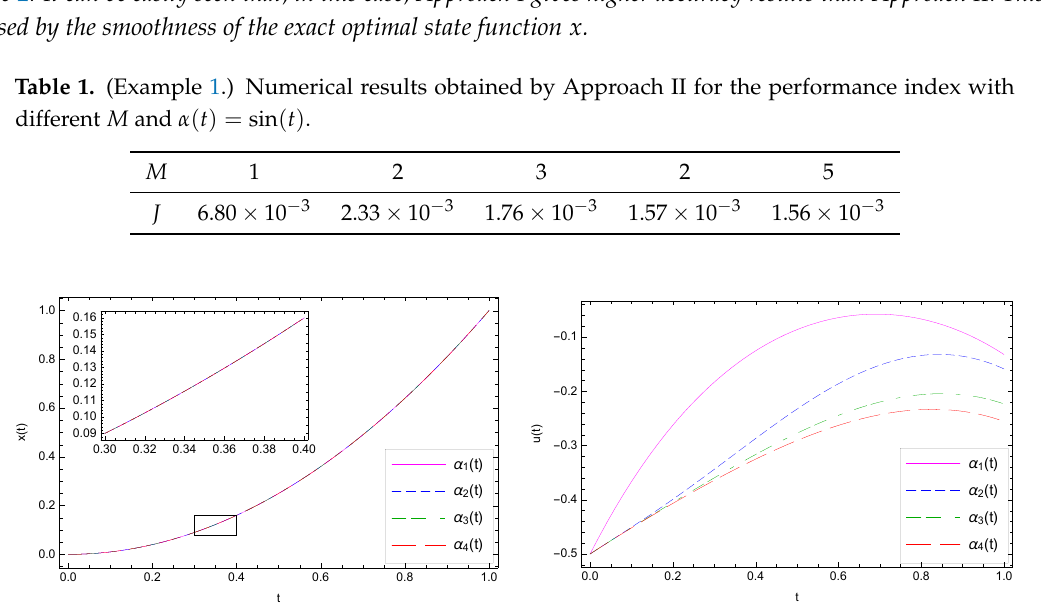
Figure 1. (Example 1.) Comparison between the approximate state ( left ) and control ( right ) functions obtained by Approach I with M = 5 and different α ( t ) (40).